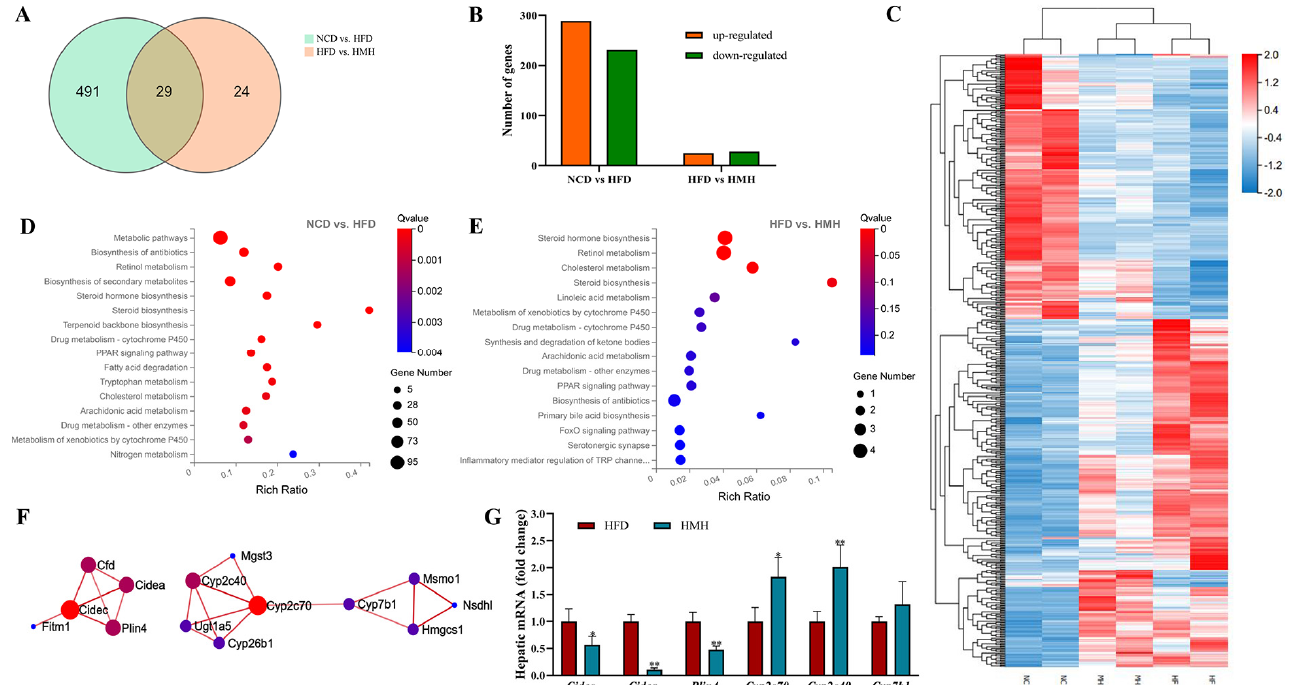
Figure 4. Effects of matcha on the liver transcriptome of mice. ( A ) Venn diagram analysis for co-expressed genes derived from RNA sequencing; ( B ) number of significantly up-regulated and down-regulated genes in comparisons of the NCD and HFD groups or HFD and HMH groups; ( C ) heatmap that shows the expression pattern of all DEGs and the hierarchical clustering of the liver samples based on the transcriptomic profiles. Red indicates upregulation, blue indicates downregulation; ( D , E ) KEGG pathway analysis of differentially expressed genes between the NCD and HFD groups or HFD and HMH groups; ( F ) Cidec and Cyp2c70 related molecular networks—the redder the color, the more significant it is; ( G ) quantitative real-time PCR of Cidec -related genes and Cyp2c70 -related genes. Data are expressed as means ± SEM (n = 3). * p < 0.05, ** p < 0.01 compare to the HFD group.